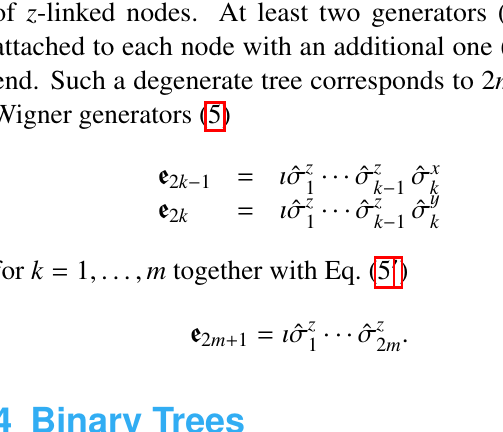
Figure 3: Binary ( x-y ) tree obtained from the ternary tree shown in Fig.